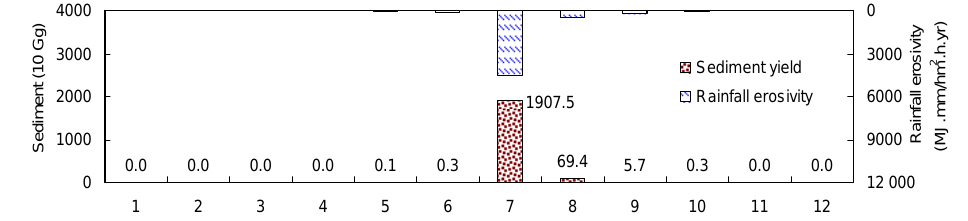
Figure 9. Comparison of monthly sediment yield and rainfall erosivity in the Majiagou River watershed in